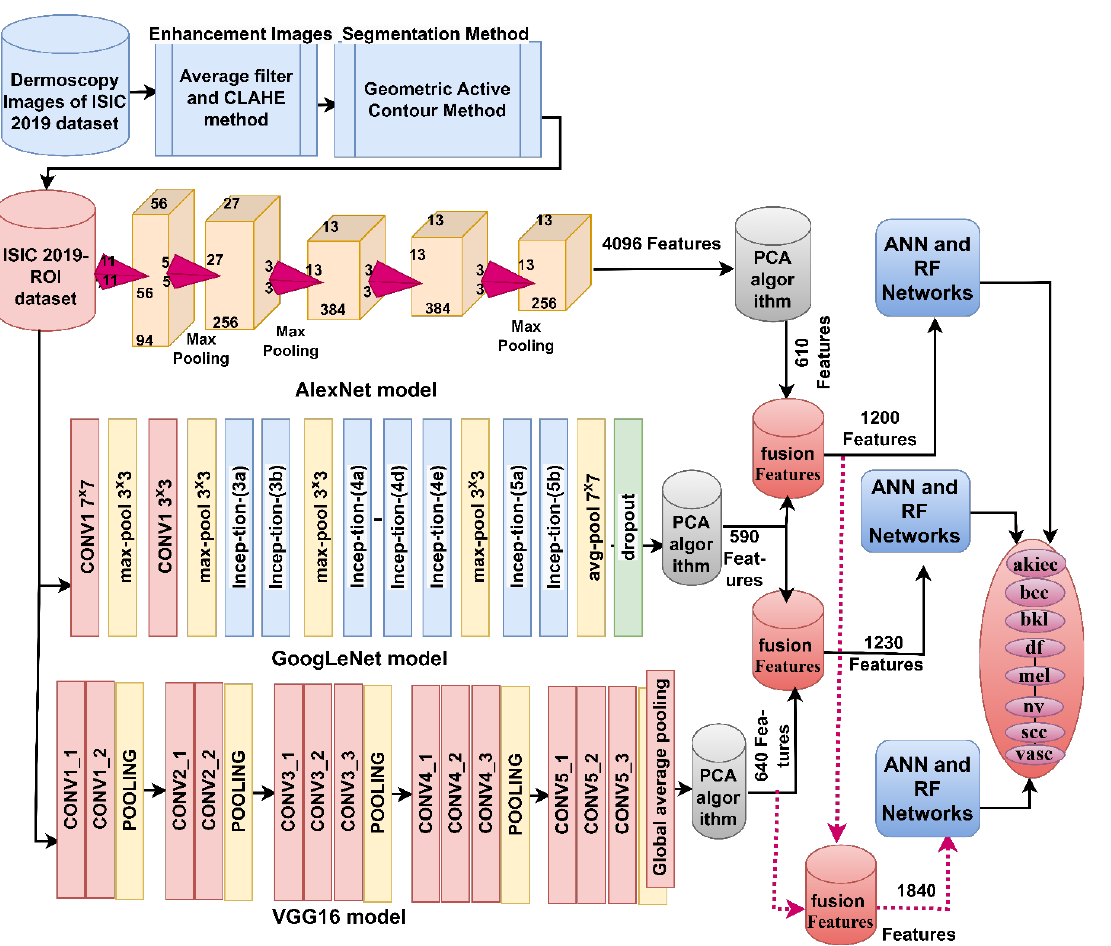
Figure 5. A hybrid model of ANN and RF with fused features of CNN for analyzing dermatoscopic images to diagnose the skin lesions of the ISIC 2019 dataset.